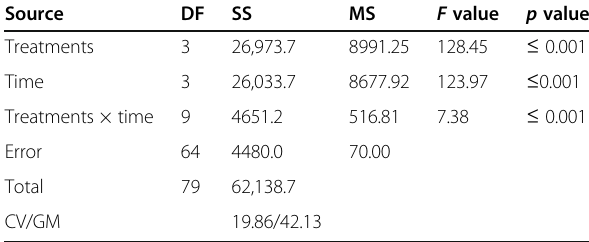
Table 3 Factorial analysis of variance of mortality of Bemisia tabaci bioassayed with the binary combinations (conidia + filtrate) of the three Lecanicillium lecanii